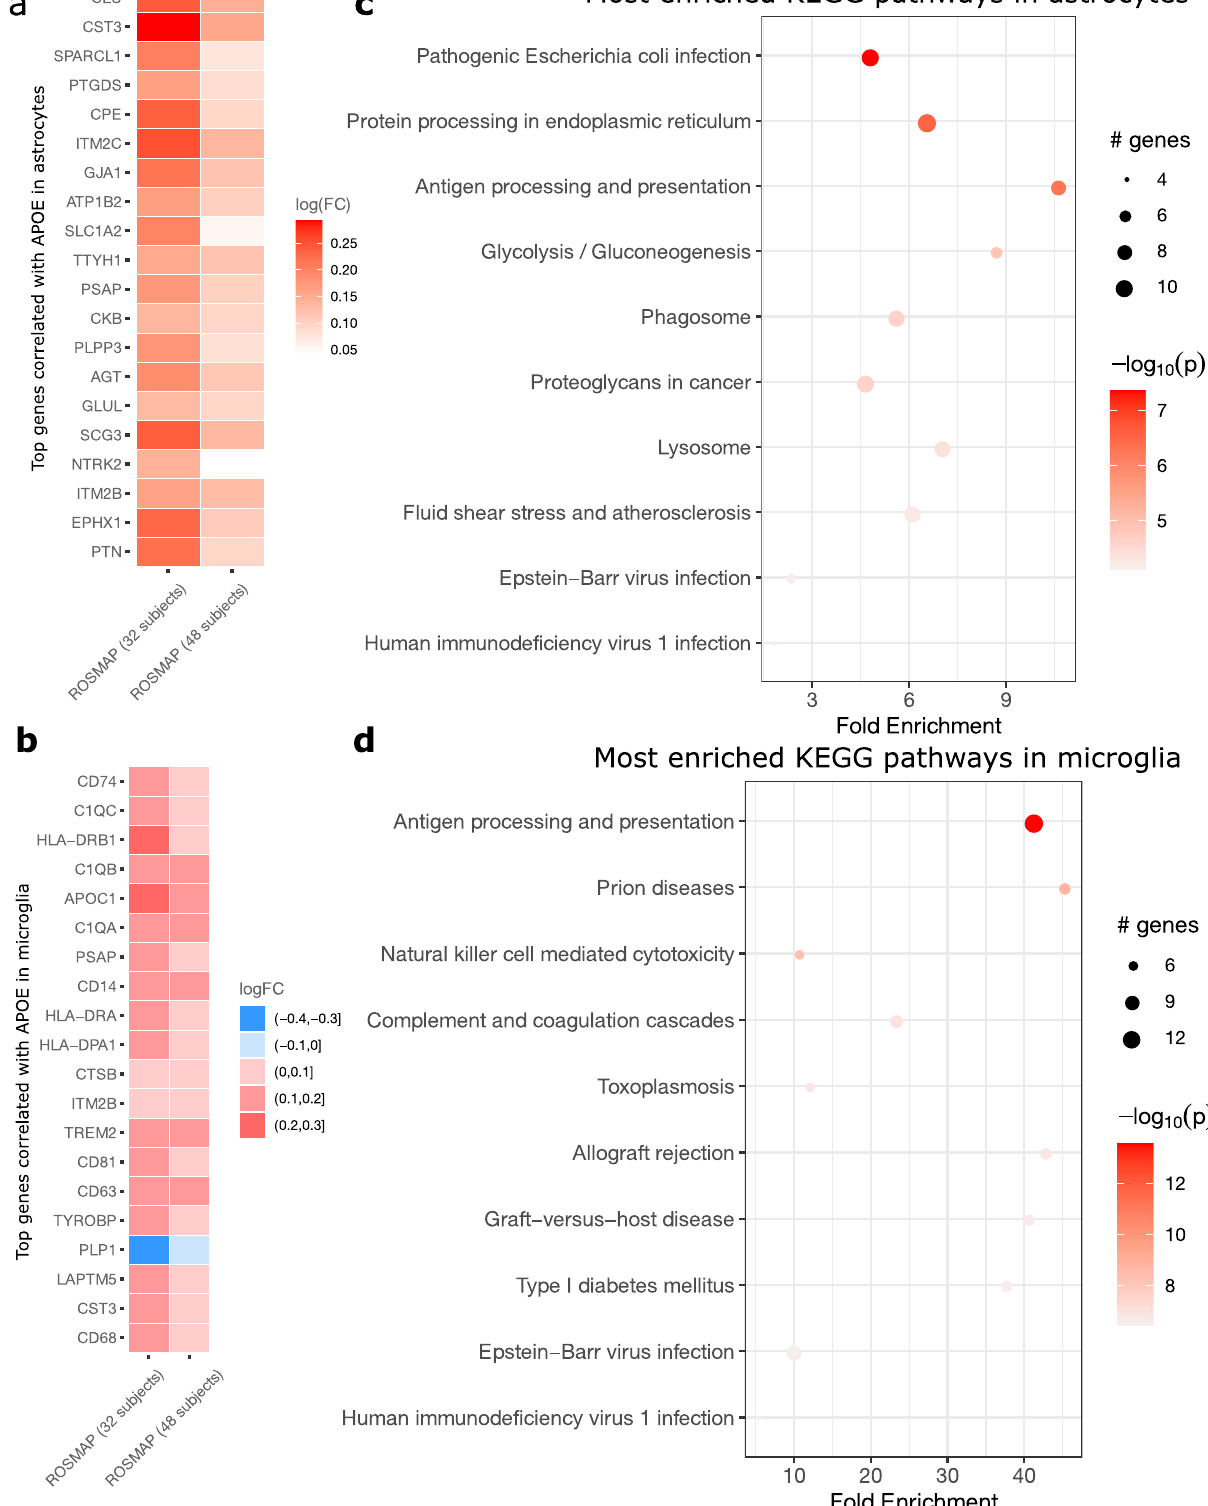
Fig. 6 Analysis of cell-level co-expression of APOE in astrocytes and microglia. a and b Top 20 genes whose expression in astrocytes (panel a) and microglia (panel b ) were correlated with the expression of APOE at the single-cell level. The correlation measured by log(FC) was obtained by NEBULA in two snRNA-seq data sets 5,78 in the frontal cortex from the ROSMAP. c and d Top 10 KEGG pathways in which the genes most correlated with APOE in astrocytes (panel c ) and microglia (panel d ) were enriched. The size of the circles indicates how many genes were found in that pathway. The color indicates the p -value of the